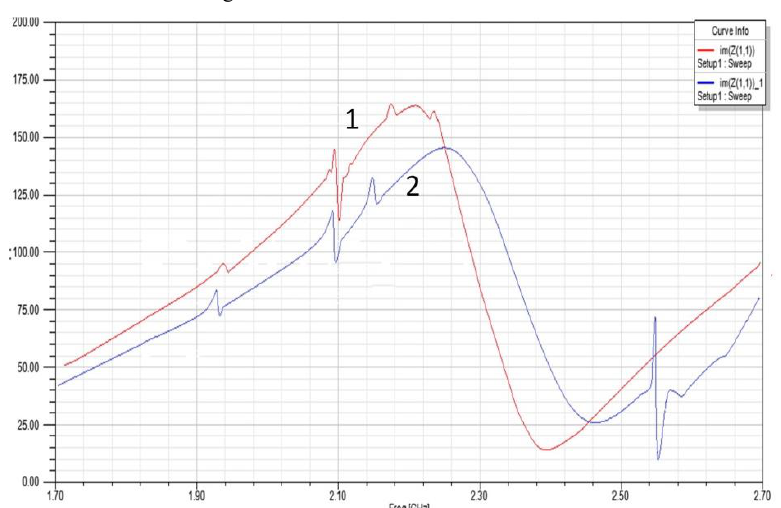
Fig. 2. The resistance of the integrated radiator.